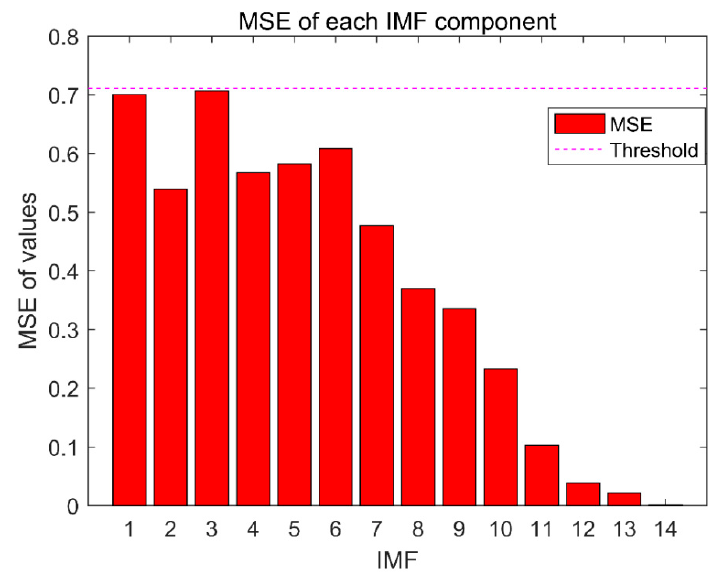
Figure 20. MSE value of the component signal (reconstructed signal is decomposed by